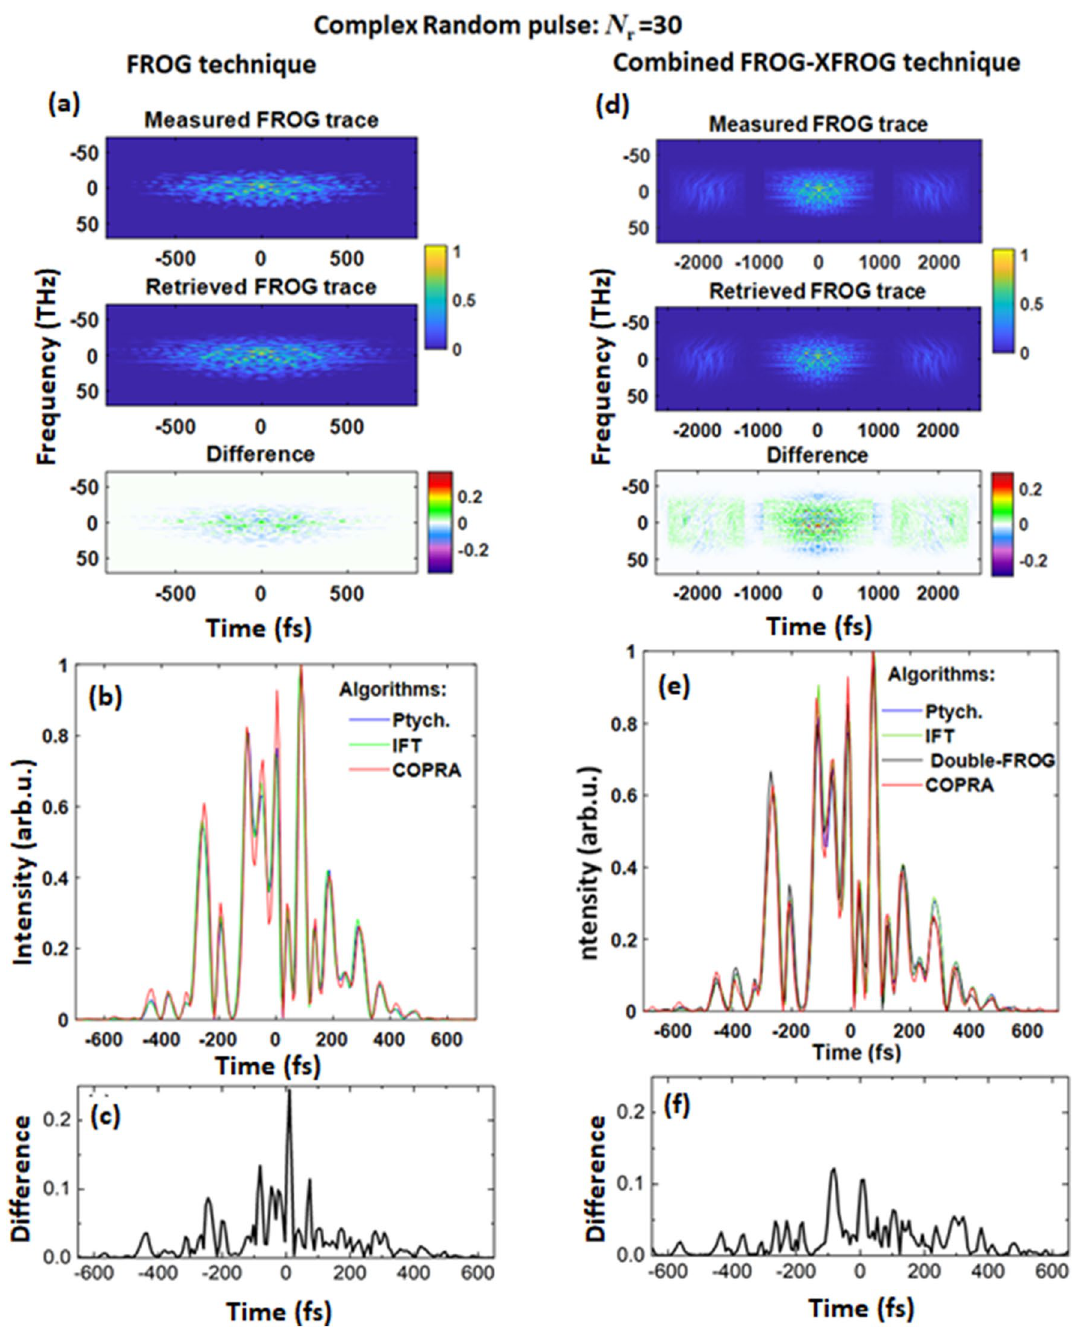
Figure 4. ( a , d ) Measured and retrieved FROG trace (electric field amplitude) of a complex random pulse: N r = 30, and the difference of the measured and retrieved traces. ( a ) FROG technique: the trace was retrieved using Eq. (1), where N = 256, T = 900, dt = 7.06 fs . ( d ) Combined FROG–XFROG technique: The trace was retrieved as a FROG trace of a double pulse, where N = 256, T = 900, dt = 7.06 fs . ( b , e ) Retrieved temporal intensity profiles using three different algorithms for FROG ( b ) and Combined FROG–XFROG ( e ) techniques. ( c , f ) Difference between the maximum and the minimum of the temporal intensity profiles for the different algorithms for FROG ( c ) and Combined FROG–XFROG ( f )